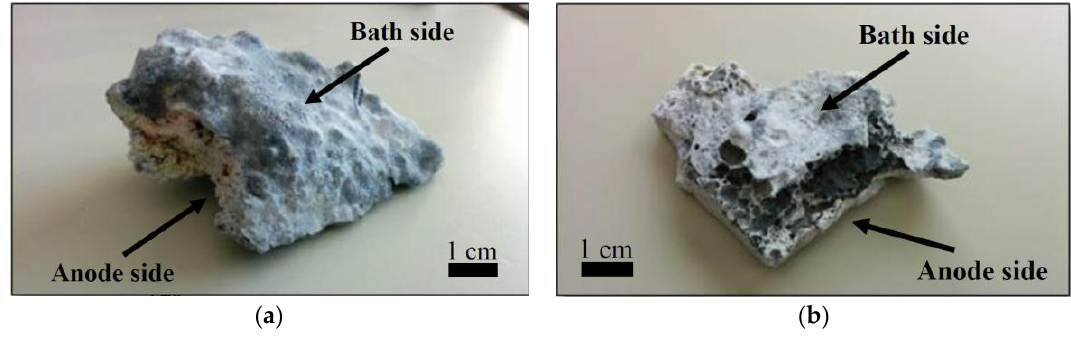
Figure 1. Photos of the frozen bath: ( a ) Sample A and ( b ) sample B. The bottom of each sample was in contact with their corresponding anode.